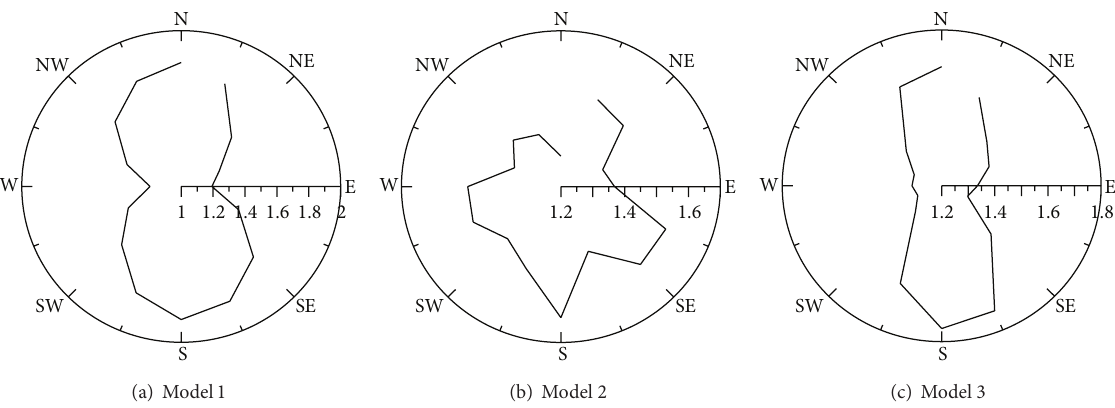
Figure 5: Distribution of the maximal wind speed ratio in each model.